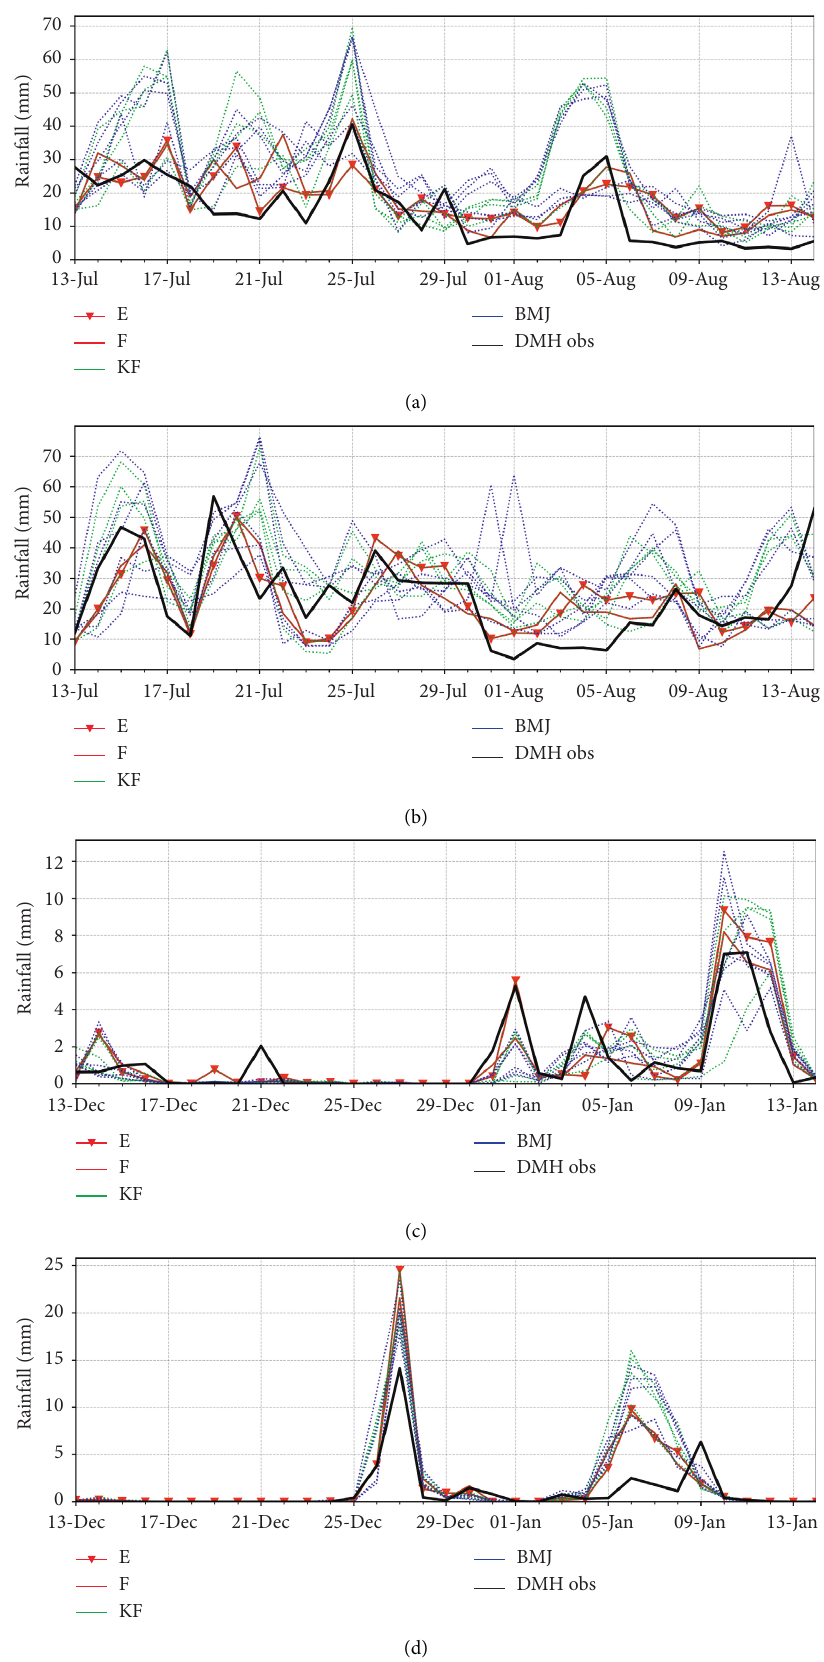
Figure 4: Time series plots of daily average rainfall for Lao PDR, highlighting the PBL physics option. Simulation with YSU scheme is given in green and that with the MYJ scheme in blue. (a) Wet season 2017, (b) wet season 2018, (c) dry season 2017, and (d) dry season